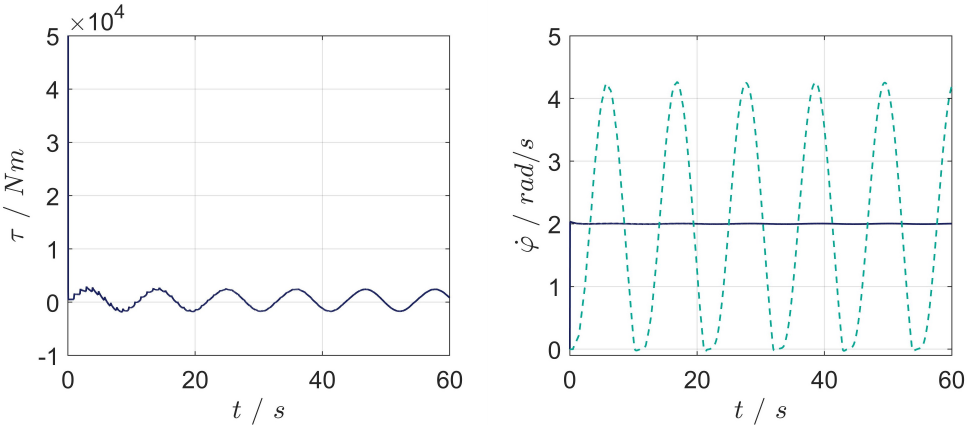
Figure 6. Step responses of the closed-loop nonlinear system applying velocity PI -controller with gain k P = 2 × 10 5 : first mass ϕ 0 (solid blue) and second mass ϕ L (dotted